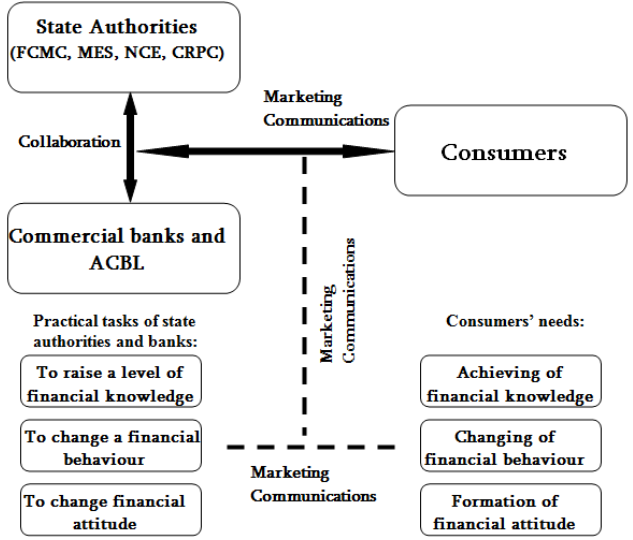
Fig. 2. The operating principle of the unified social marketing model in financial literacy level rising within home loan market (designed by